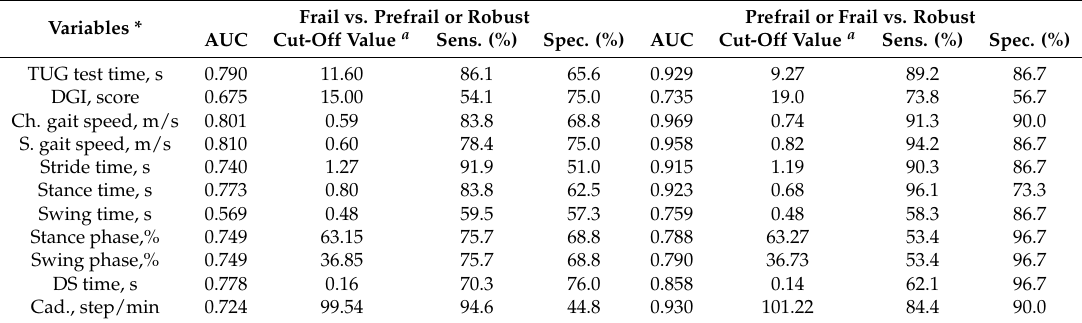
Table 5. The most sensitive parameters for discriminating frail from prefrail or robust and prefrail or frail from